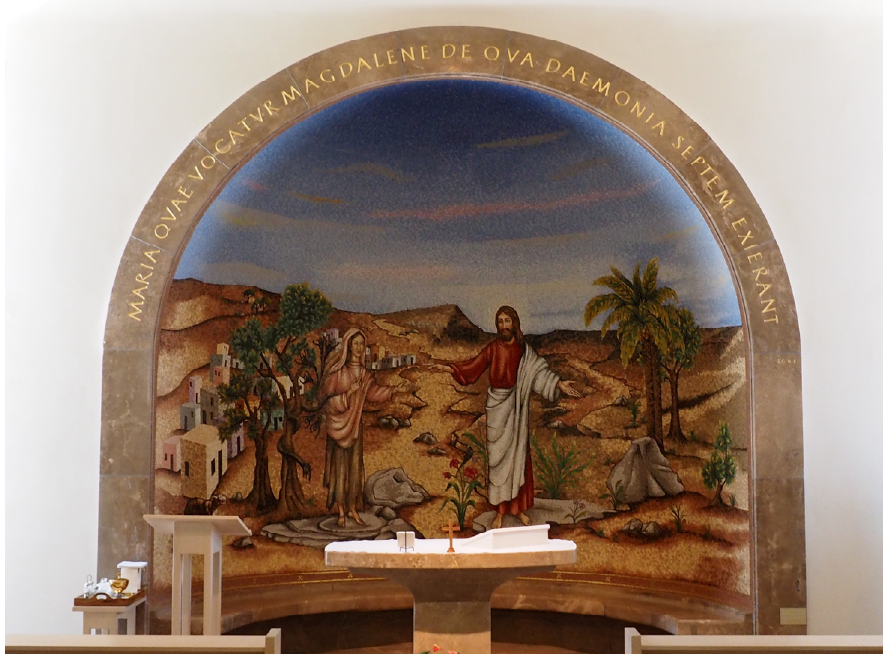
Figure 9. Christ driving out the seven demons from Mary Magdalene (photo: Assaf Pinkus).